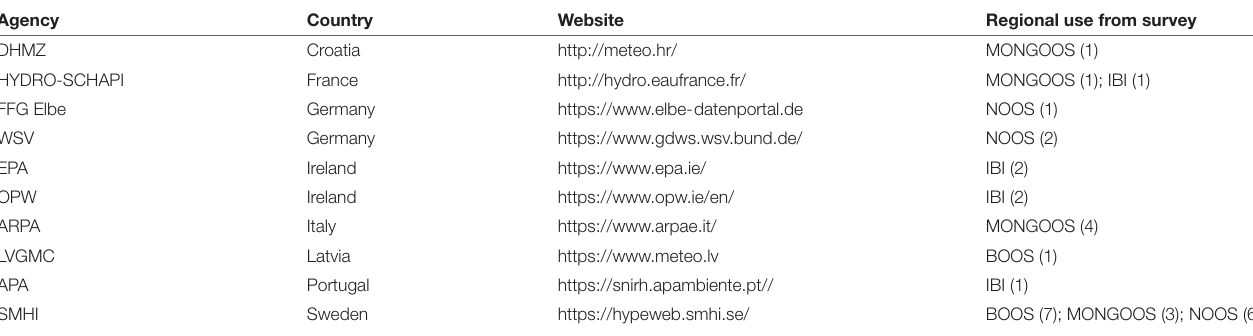
TABLE 4 | Reference website of national providers of land runoff forcing mentioned in the survey. Agency Country Website Regional use from